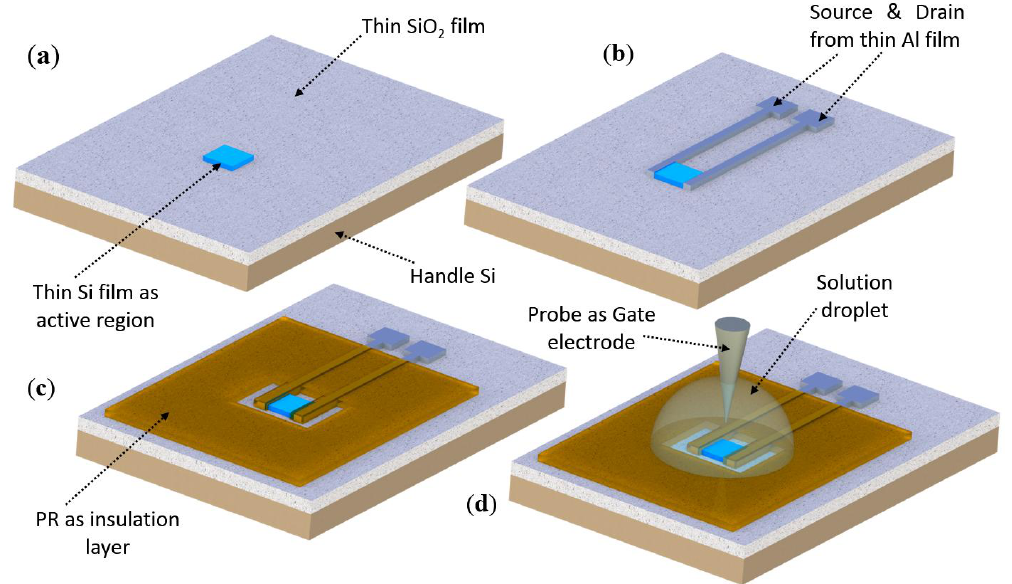
Figure 2. Fabrication steps of WG-FET: ( a ) Wet etching of thin film silicon to pattern the active region;